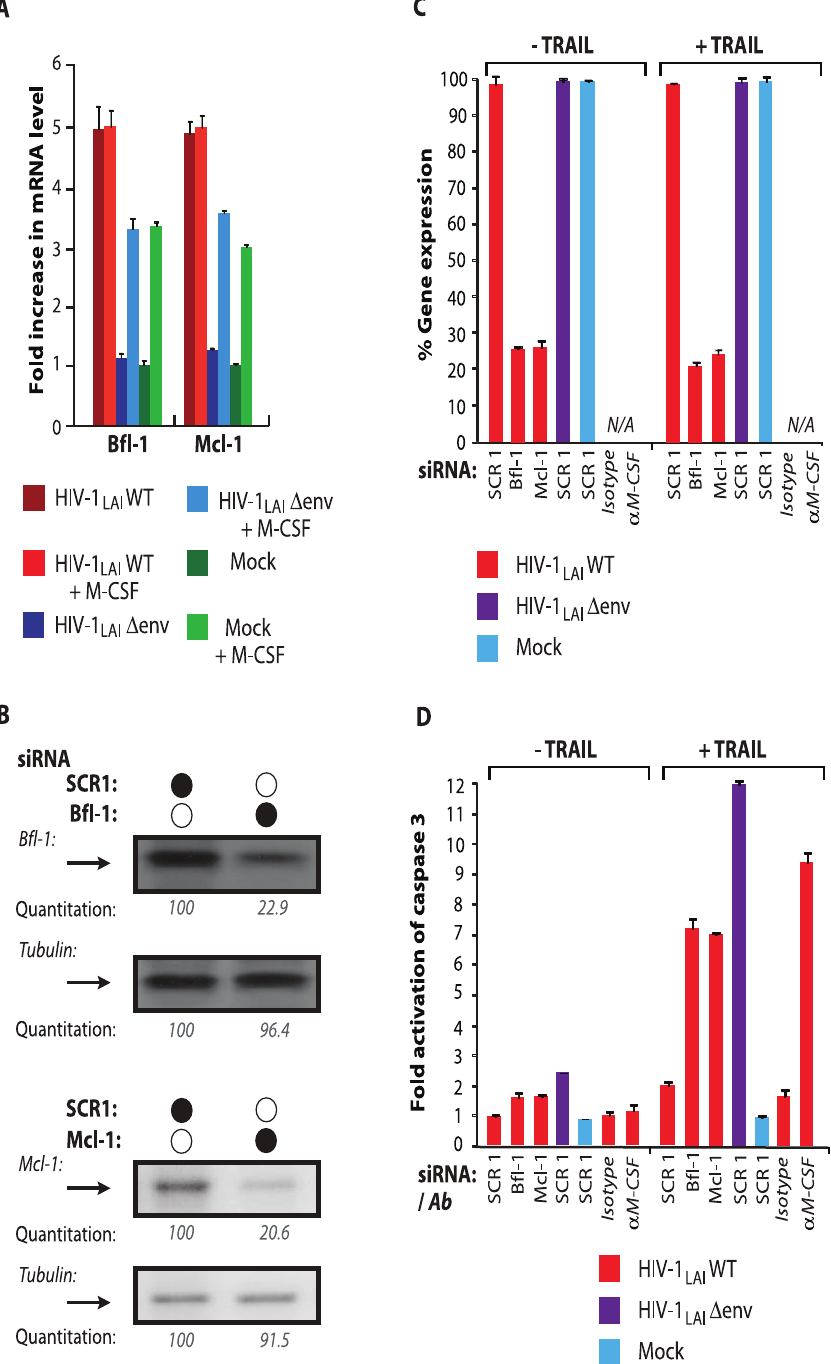
Figure 4. M-CSF Upregulates Host Anti-Apoptotic Genes to Mediate Resistance of Infected Macrophages to TRAIL (A) mRNA levels for the anti-apoptotic genes Bfl-1 and Mcl-1 were measured by ribonuclease protection assay in HIV-1 wild type– and D env-infected macrophage cultures incubated in the presence or absence of M-CSF. (B) RNAi effectively mediated substantial reduction in Bfl-1 and Mcl-1 protein levels in human macrophages. Protein levels were determined by Western blotting and normalized to signals from tubulin. (C) RNAi-mediated Bf1–1 and Mcl-1 knockdown of mRNAs. mRNA levels, determined by quantitative RT-PCR, are shown as percentage relative to a scrambled siRNA (SCR1) (error bars, SD). (D) Bfl-1 and Mcl-1 are required for protection from TRAIL-mediated apoptosis. Macrophages were transfected with Mcl-1, Bfl-1, or a nontargeting control (SCR1) siRNA. Sixteen hours later, macrophages were treated with soluble TRAIL, or an antibody to M-CSF, and apoptosis was determined by ELISA for active (cleaved) caspase 3 (error bars, SD).